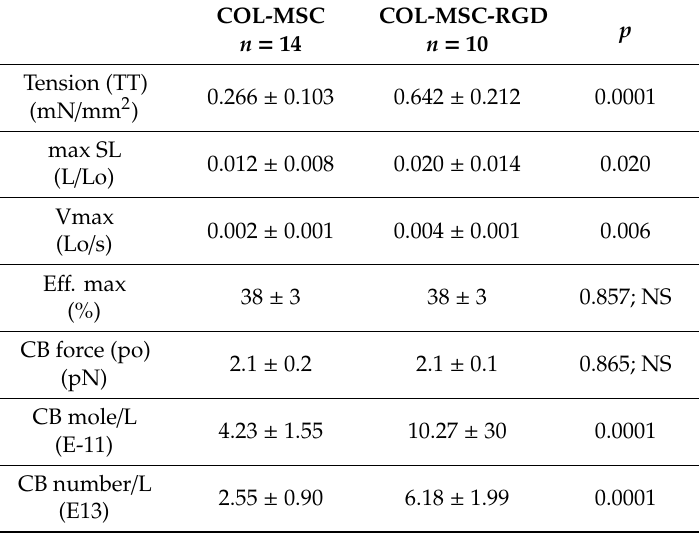
Table 1. Classical mechanical parameters of COL-MSC and COL-MSC-RGD sca ff olds and molecular properties of NMMIIA CBs.